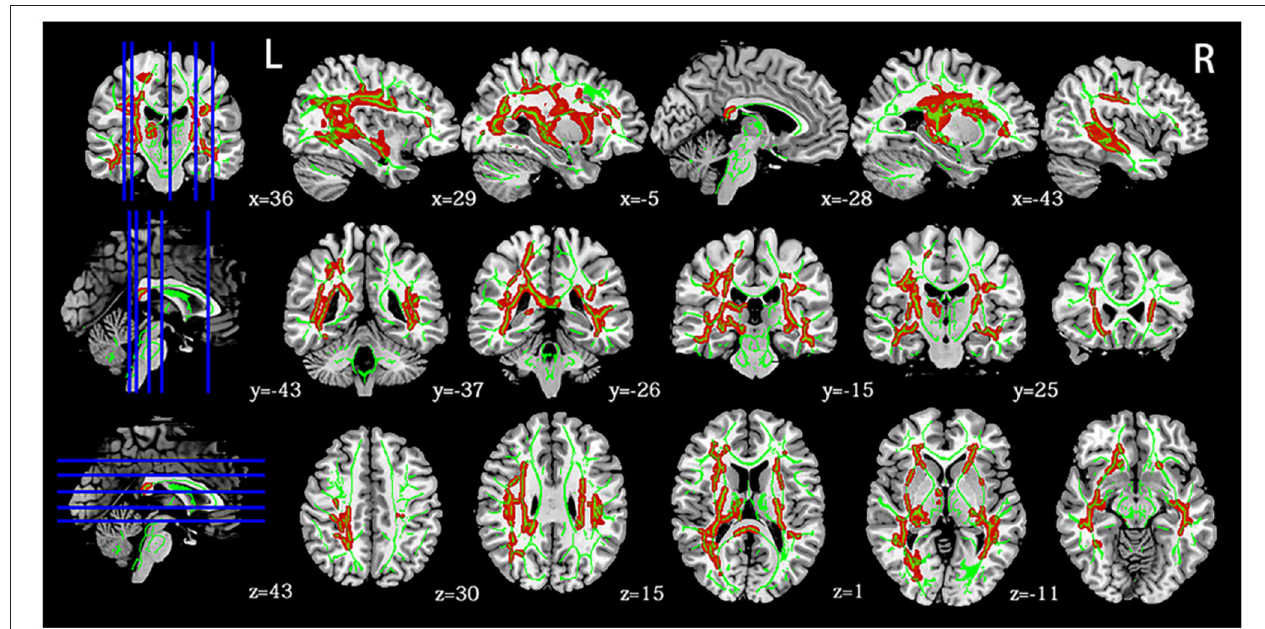
TABLE 2 | The anatomical distribution with increased FA in acute mTBI group.